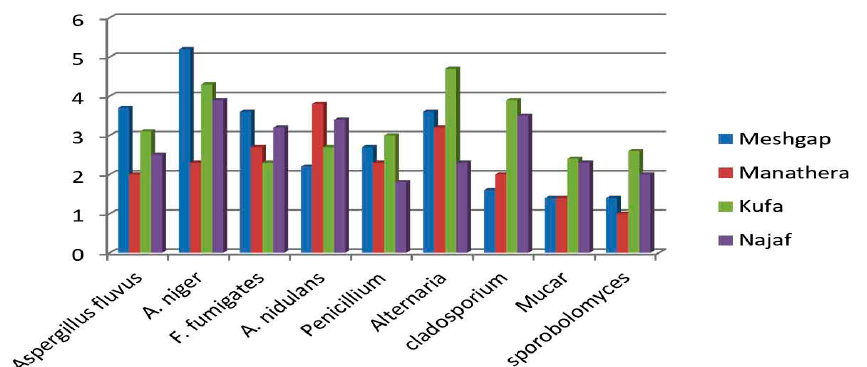
Fig. 1. The type and percentage of fungal spore distributed according to districts